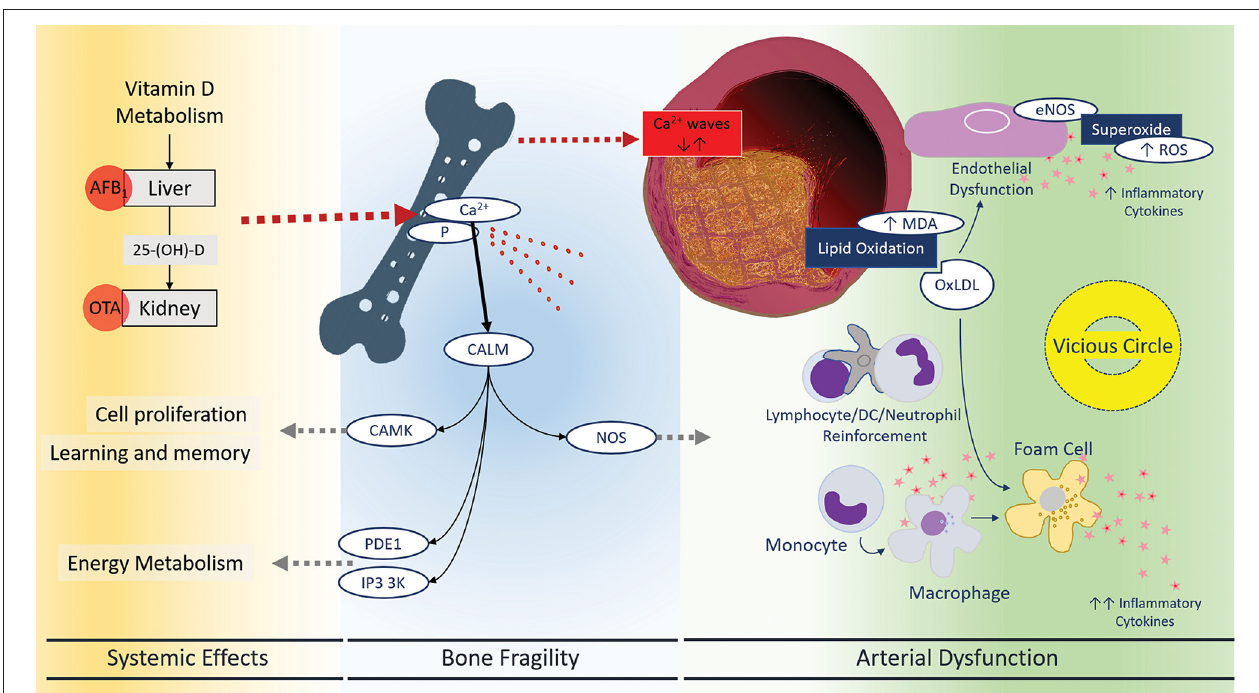
FIGURE 2 | Systemic effects of mycotoxins leading to bone fragility and arterial dysfunction. There has been a meaningful connection between oxidative status and atherosclerotic vascular diseases. Now, mycotoxins are assumed to be an important environmental factor disrupting and or modulating oxidative and immune mechanisms in the blood vessels. Endothelial dysfunction, lipid peroxidation, and foam cell formation are three main characteristics of vascular inflammation: inflammatory responses and immune cell reinforcement. Mycotoxins can restore this vicious circle that may explain the high risk of stroke, heart attack, and PAD. CALM, Calmodulin 1–6, CAMK, calcium/calmodulin-dependent protein kinases, PDE1, phosphodiesterases, IP3 3K, inositol-trisphosphate 3-kinases, NOS, nitric oxide